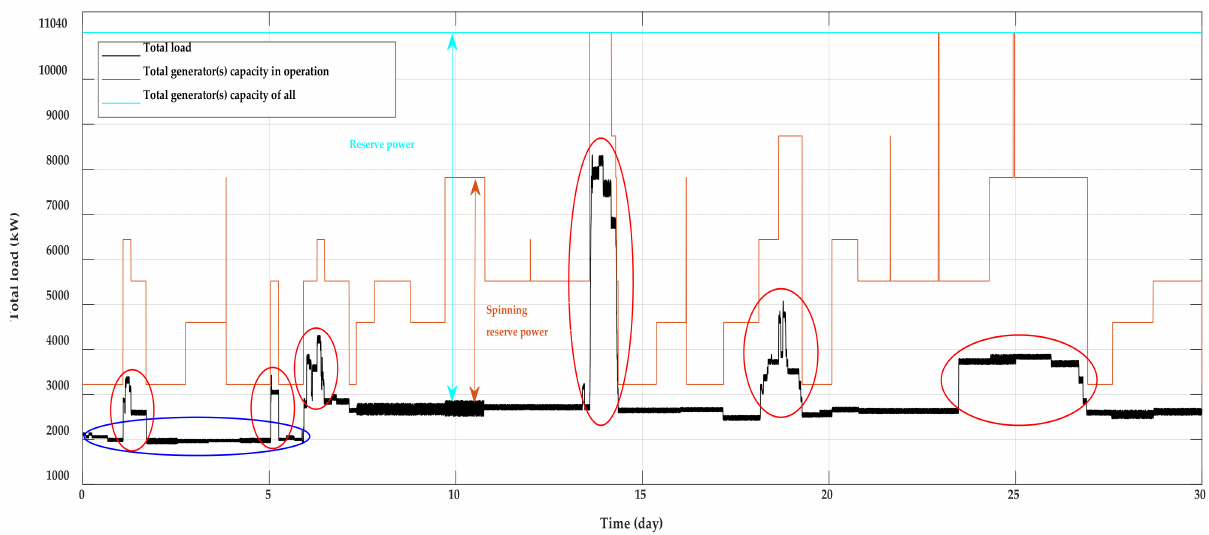
Figure 4. Reserve power and reserve rate of the